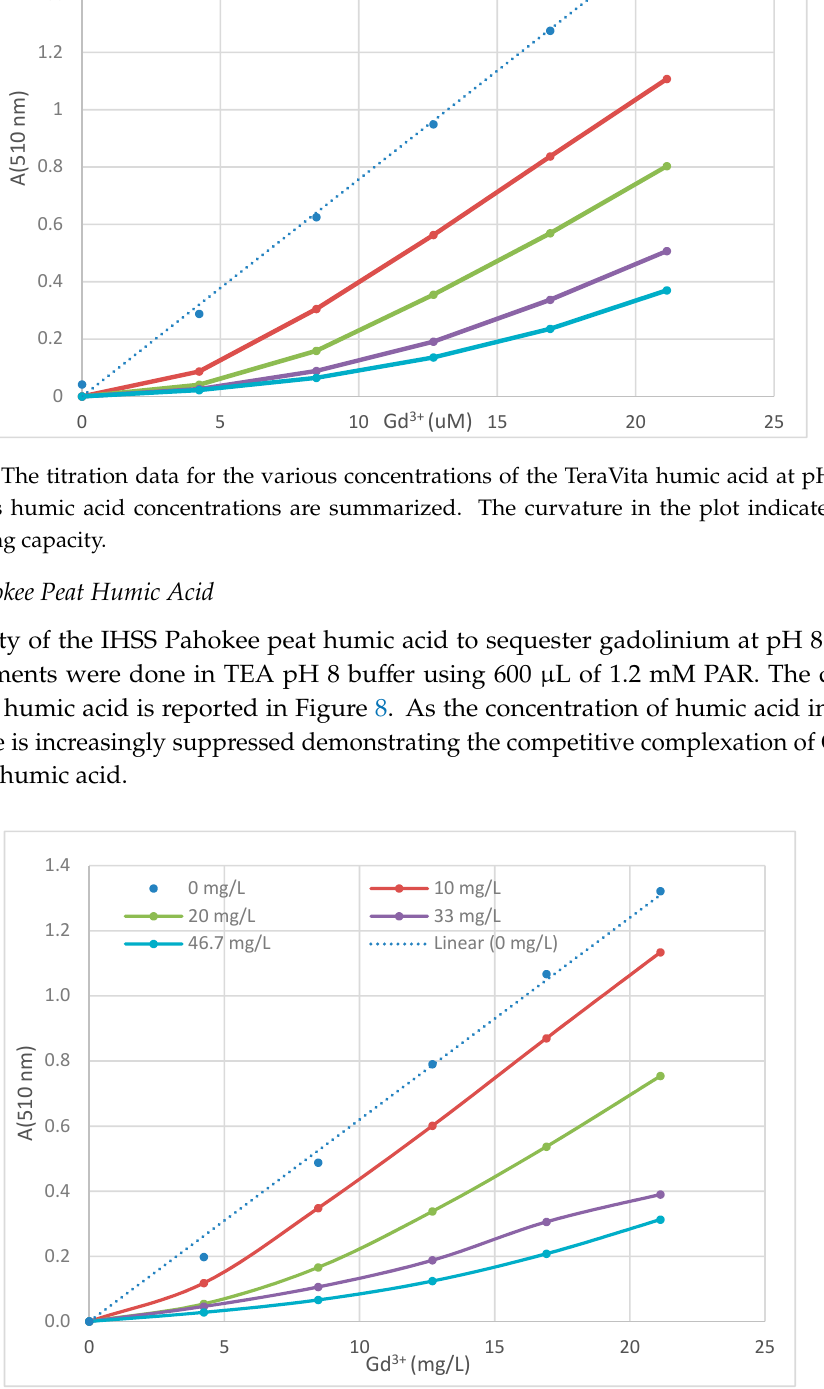
Figure 8. The data for the titration with Gd 3 + of Pahokee Peat humic acid at pH 8 and at various concentrations is summarized in this figure. The curvature in the plot indicates finite complexing